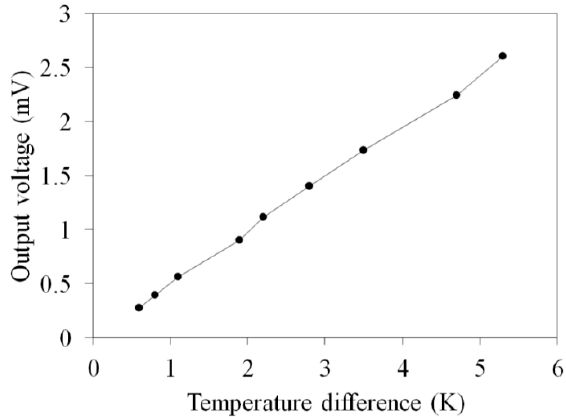
Figure 8. Measurements for the output voltage of the flexible thermoelectric generator.